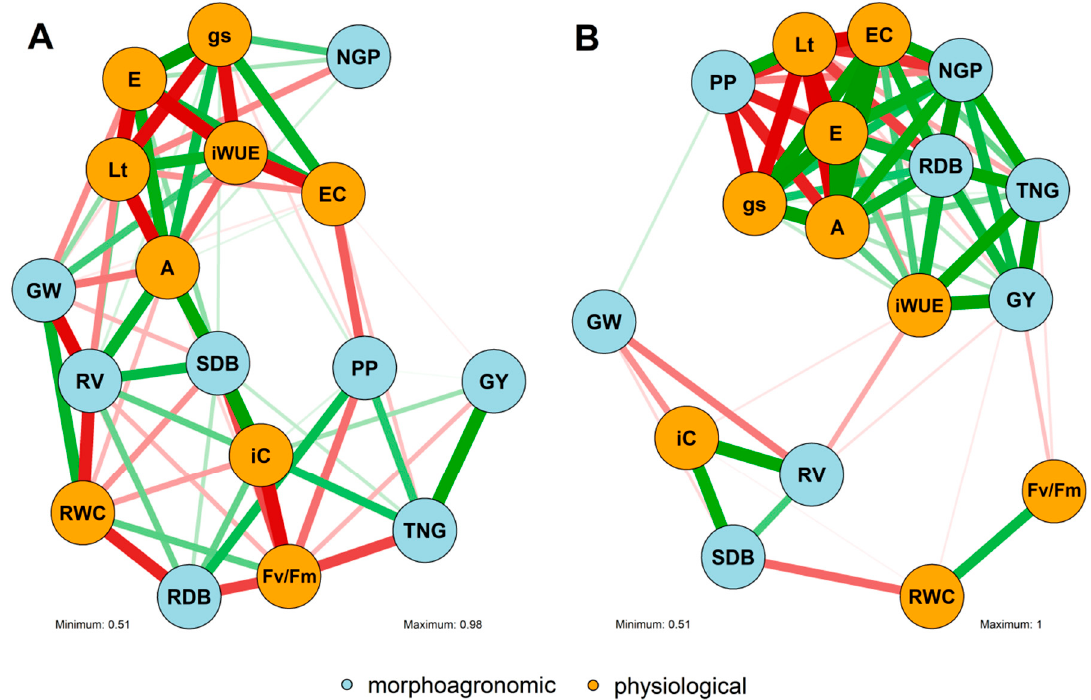
Figure 3. Network of correlations of morphoagronomic and physiological traits of common bean ( Phaseolus vulgaris L.) cultivars grown under control ( A ) and water deficit ( B ). The green and red lines represent positive and negative correlations, respectively. The thickness of the lines is proportional to the strength of the correlation. Morphoagronomic traits: shoot dry biomass (SDB); root dry biomass (RDB); root volume (RV); number of pods per plant (PP); number of grains per pod (NGP); total number of grains per plant (TNG); 100-grain weight (GW); and grain yield per plant (GY). Physiological traits: net photosynthesis rate ( A ); transpiration ( E ); stomatal conductance ( g s ); intracellular concentration of CO 2 ( iC ); intrinsic water-use efficiency ( i WUE); maximum photochemical efficiency of photosystem II ( F v / F m ); relative leaf water content (RWC); carboxylation efficiency (CE); and leaf temperature (Lt).